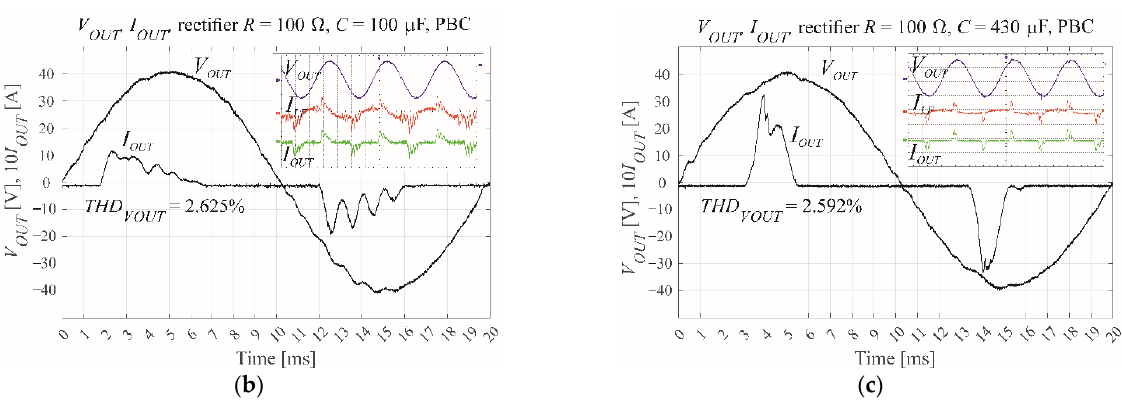
Figure 14. Overview of the VSI as controlled by IPBC2 via the STM32F407VG microprocessor, showing ( a ) scaling of the output voltage measurement, ( b ) measured output voltage and current with R = 100 Ω, C = 100 μF, and M = 0.6, and ( c ) measured output voltage and current with R = 100 Ω, C = 430 μF, and M = 0.6.